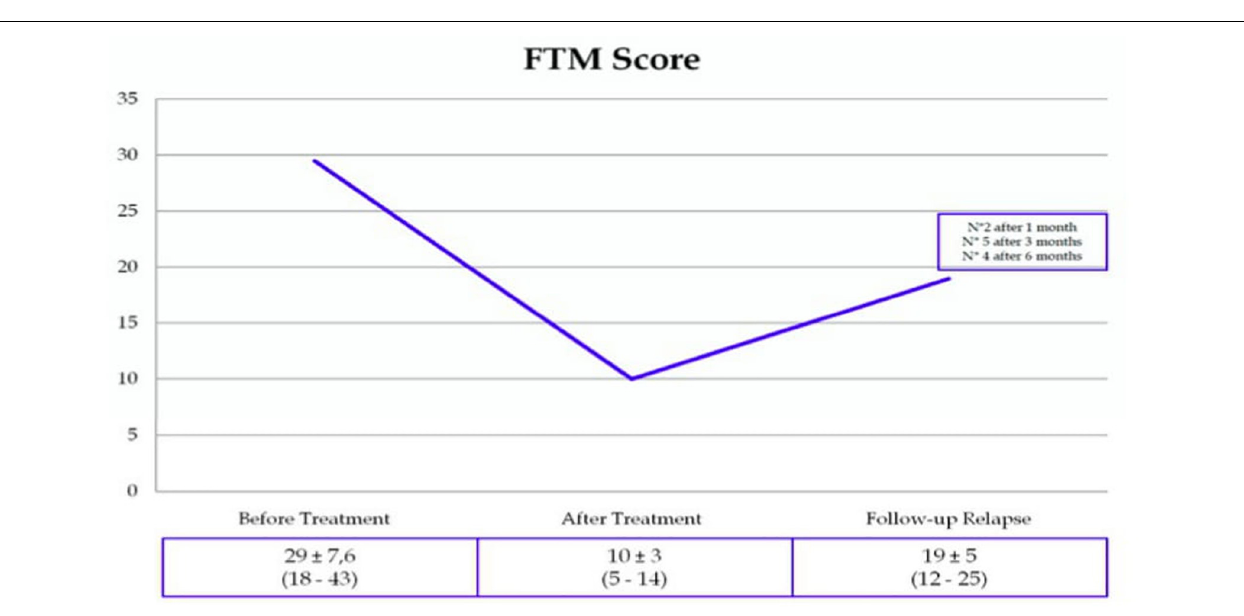
FIGURE 2 | Tremor Recurrence (13%), as estimated in a cohort of MRgFUS-treated ET patients (Sucapane,